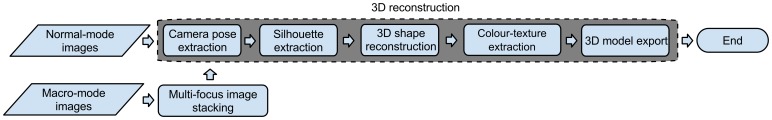
Image processing pipeline for normal-mode and macro-mode images.Macro-mode images require an extra step to stack each set of multi-focus images captured from the same viewing angle (but at different depth distances) into a single in-focus image.